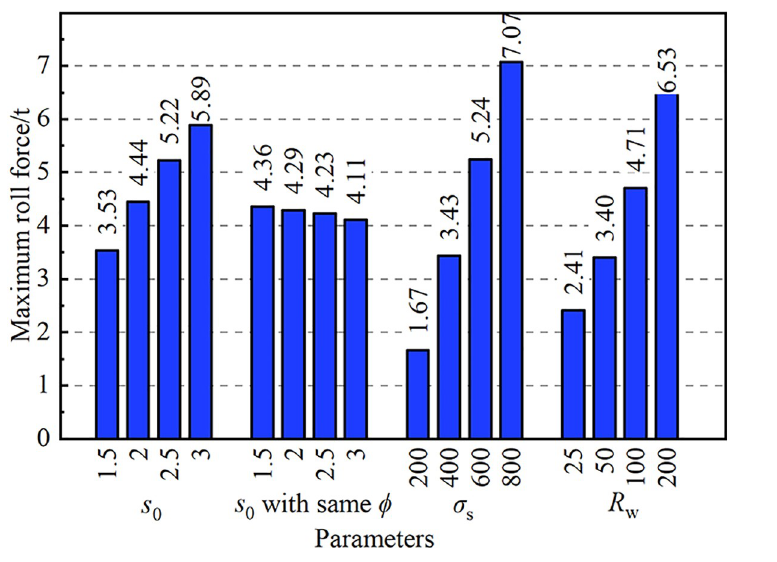
Fig 12. Effect of parameters on maximum roll force.